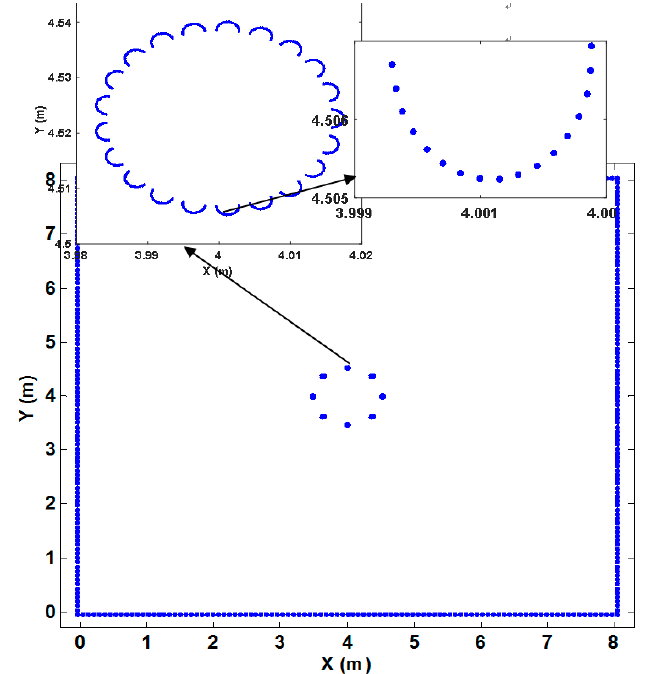
Figure 6. Simulation charge arrangement in the corona cage with eight bundled conductors.